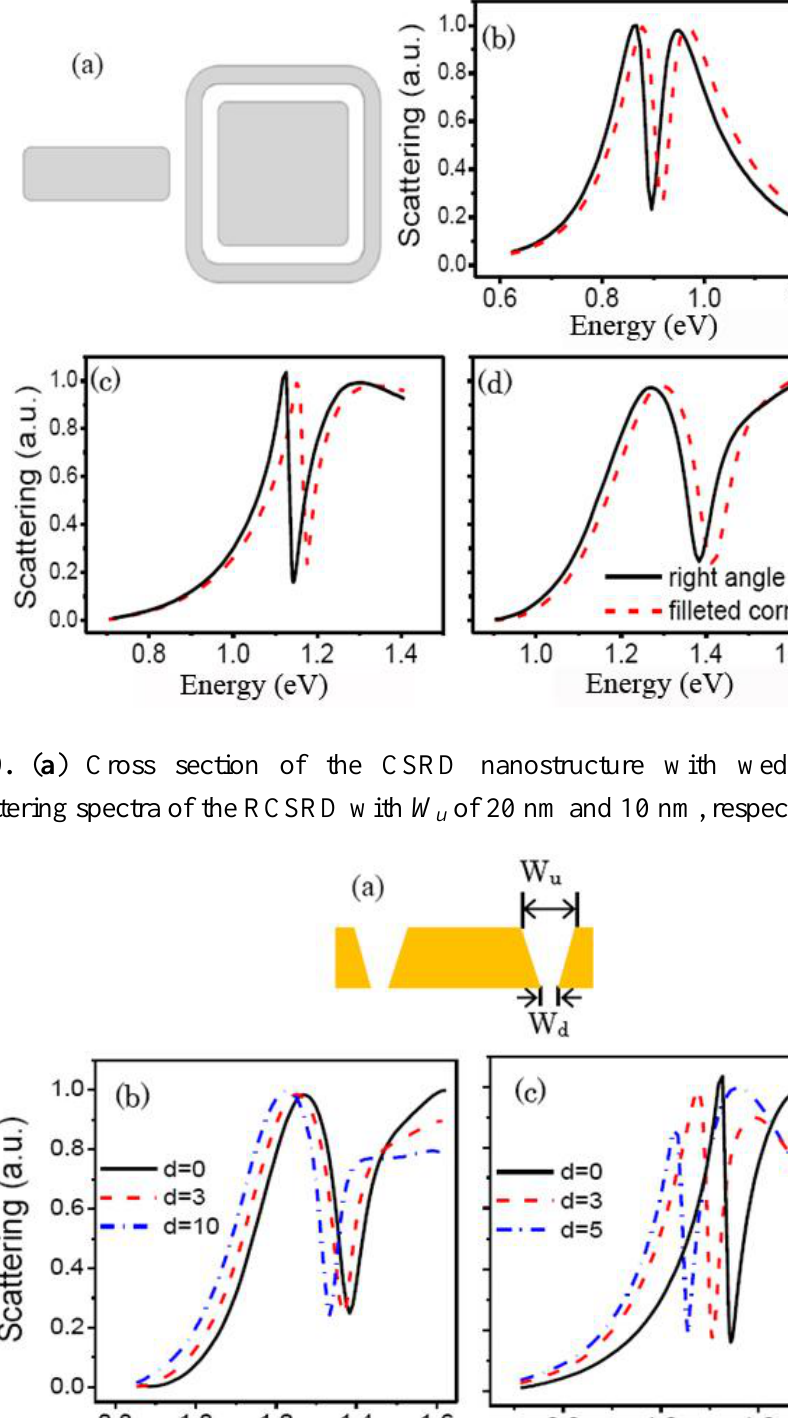
Figure 8. ( a ) Sketch of the RCSRD with filleted corner; ( b – d ) Scattering spectra of the RCSRD with the gap g of 5 nm, 10 nm and 20 nm, respectively.